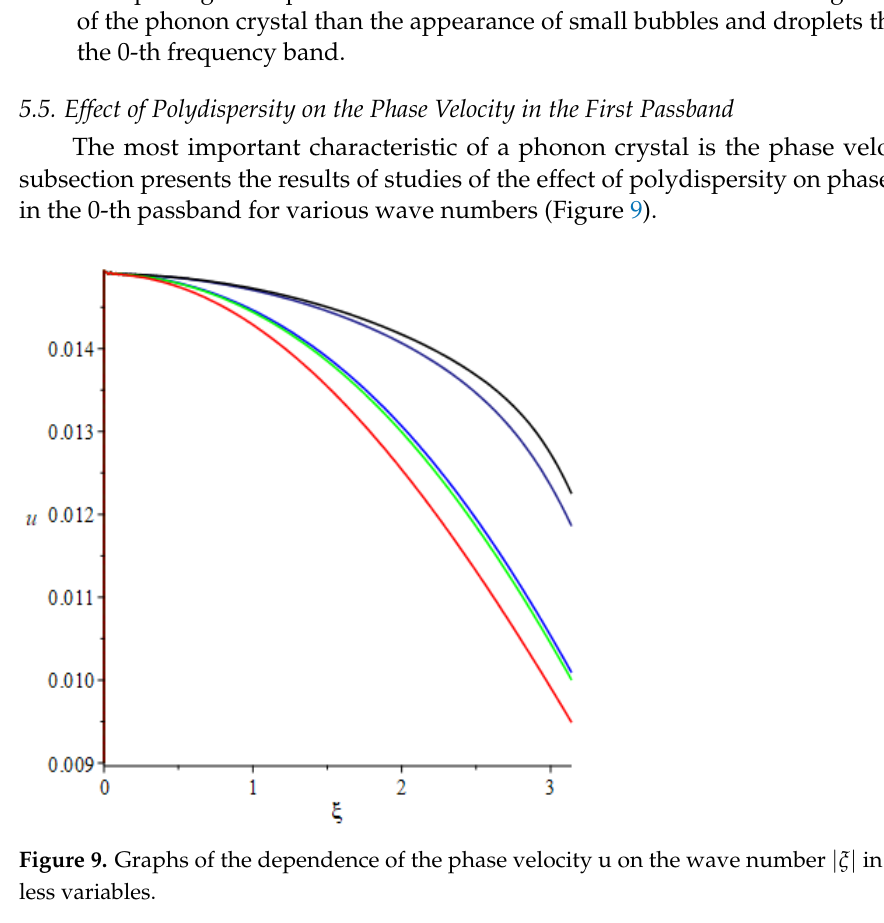
Black color: big drop + big bubble + a small drop + a small bubble with dimensions